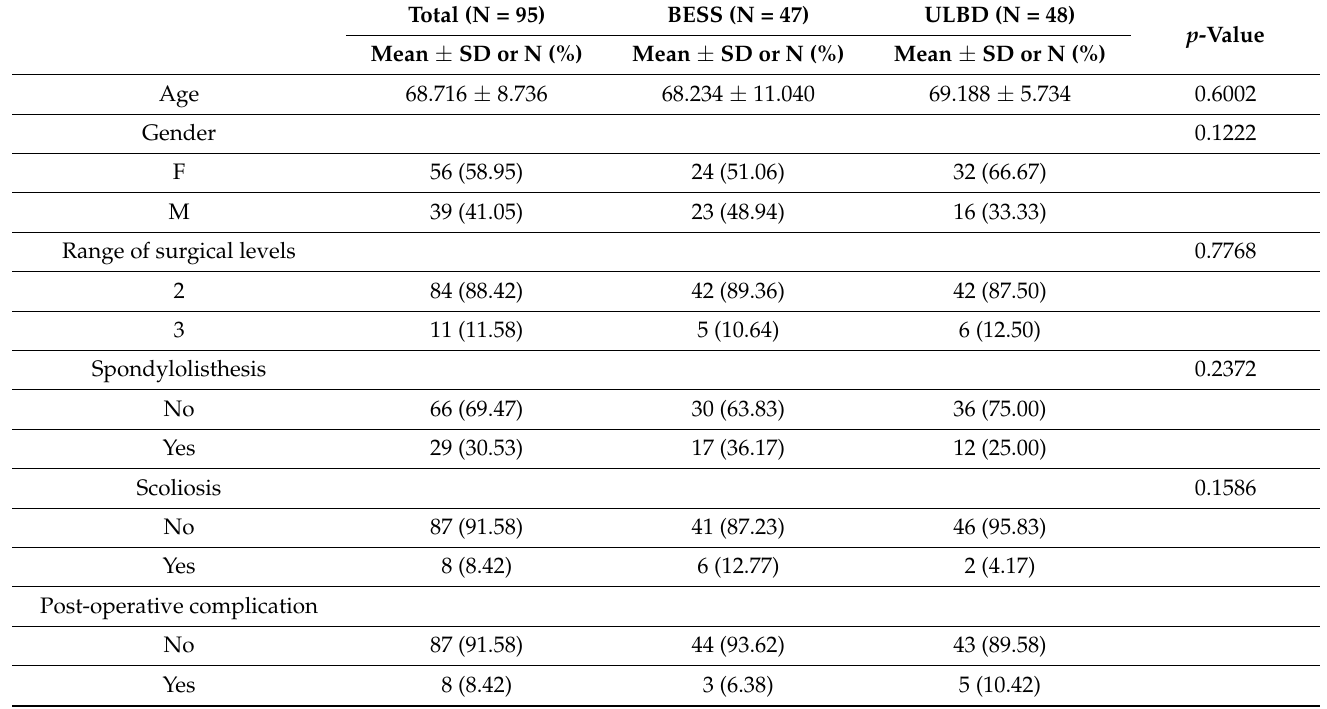
Table 1. Patient demographics.